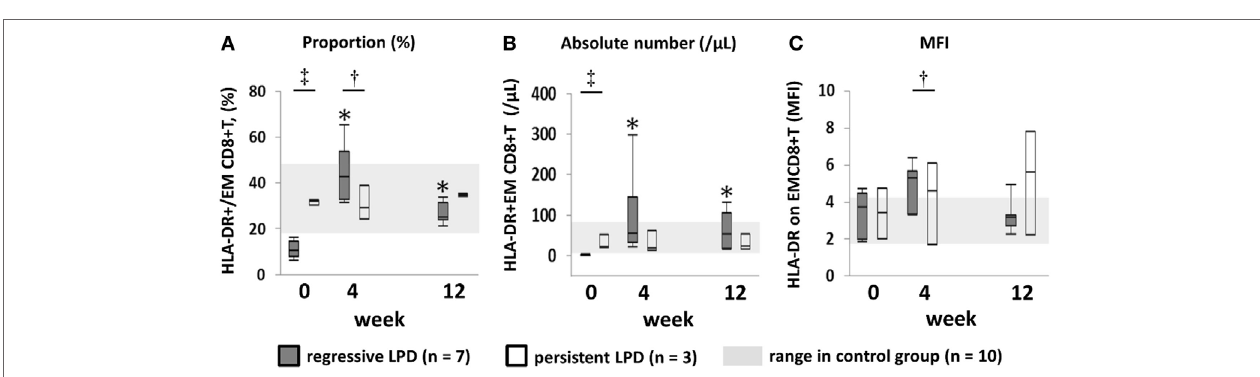
Figure 6 | Transition of proportion and absolute number of activated EMCD8 + T cell, mean fluorescence intensity (MFI) of HLA-DR on EMCD8 + T cell after methotrexate (MTX) cessation. Transition of (a) proportion and (B) absolute number of activated EMCD8+T cell, (c) MFI of HLA-DR onEMCD8+ T cell after MTX cessation. Comparison between the three groups was conducted by Kruskal–Wallis test, and comparison between two groups was conducted by Wilcoxon test. † Regressive vs. Control, P < 0.05. ‡ Regressive vs. Control, P < 0.05; Regressive vs. Persistent, P < 0.05. * P < 0.05 for the comparison with the value at week 0 in each group. EM, effector memory.